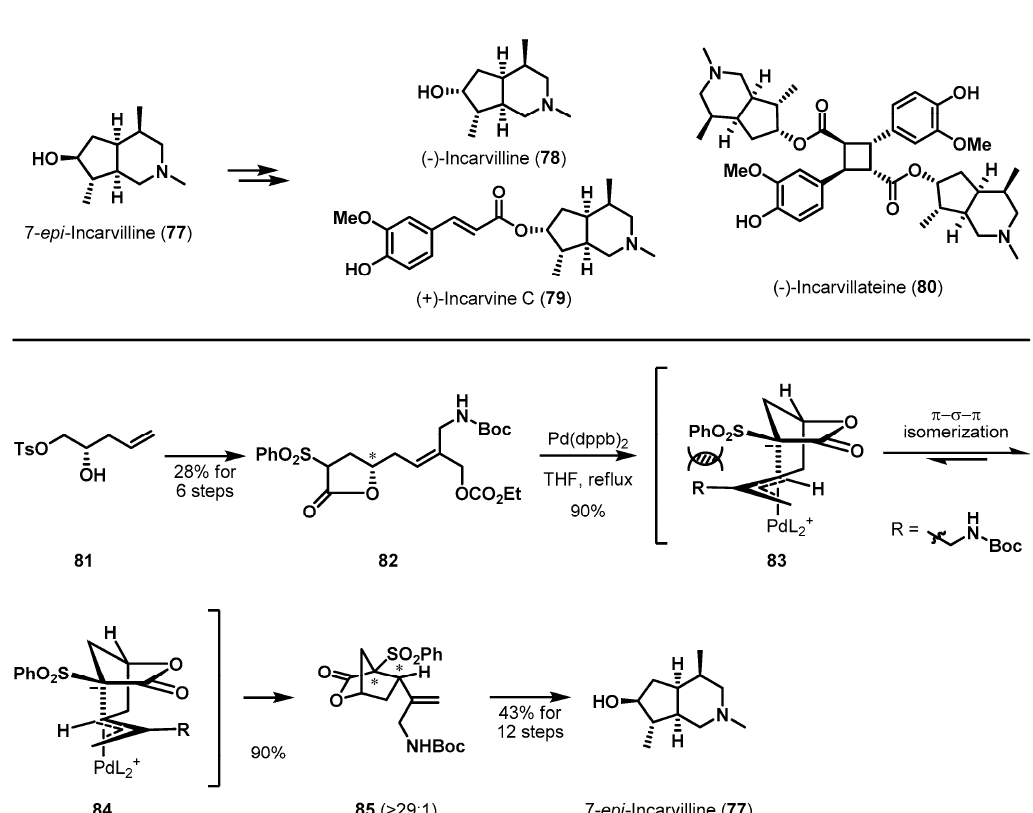
Scheme 12. Synthesis of 7- epi -incarvilline ( 77 ).